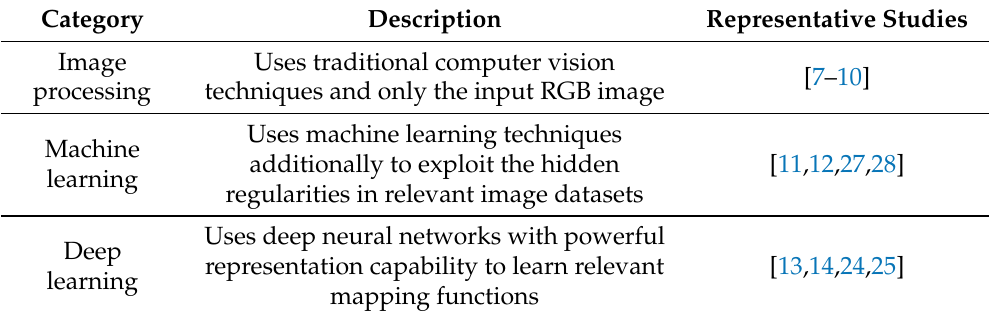
Table 2. Summary of image dehazing